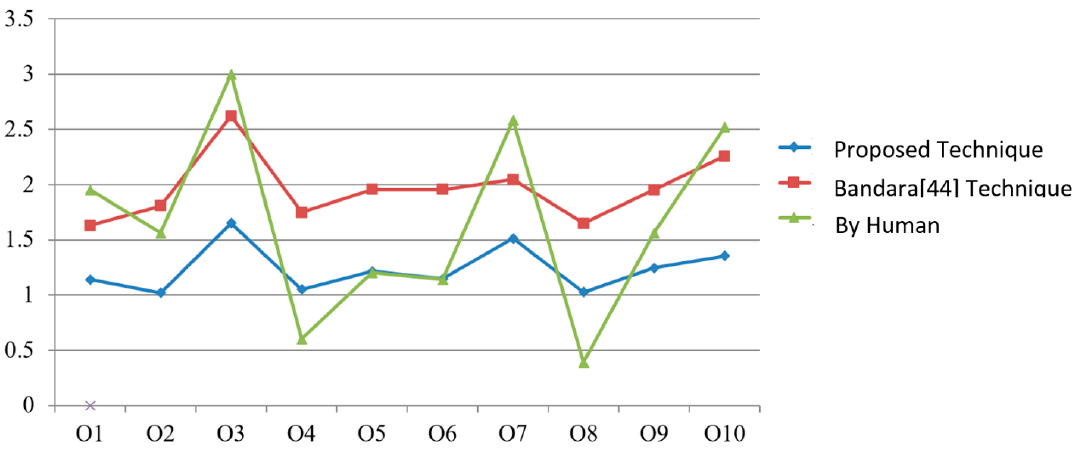
Figure 4. Comparison of service scores of different techniques.